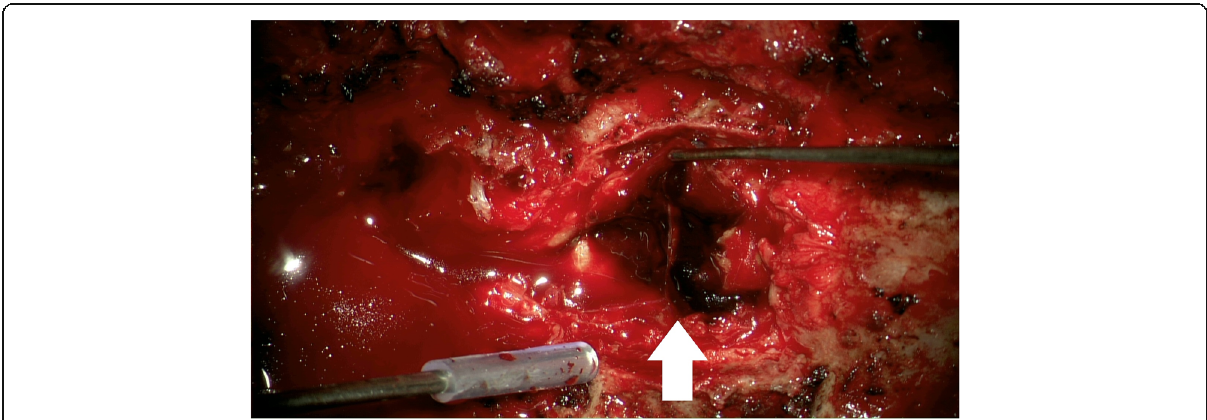
Fig. 2 Total laminectomy from T3 to T5 and evacuation of epidural hematoma (red-colored mass) was performed